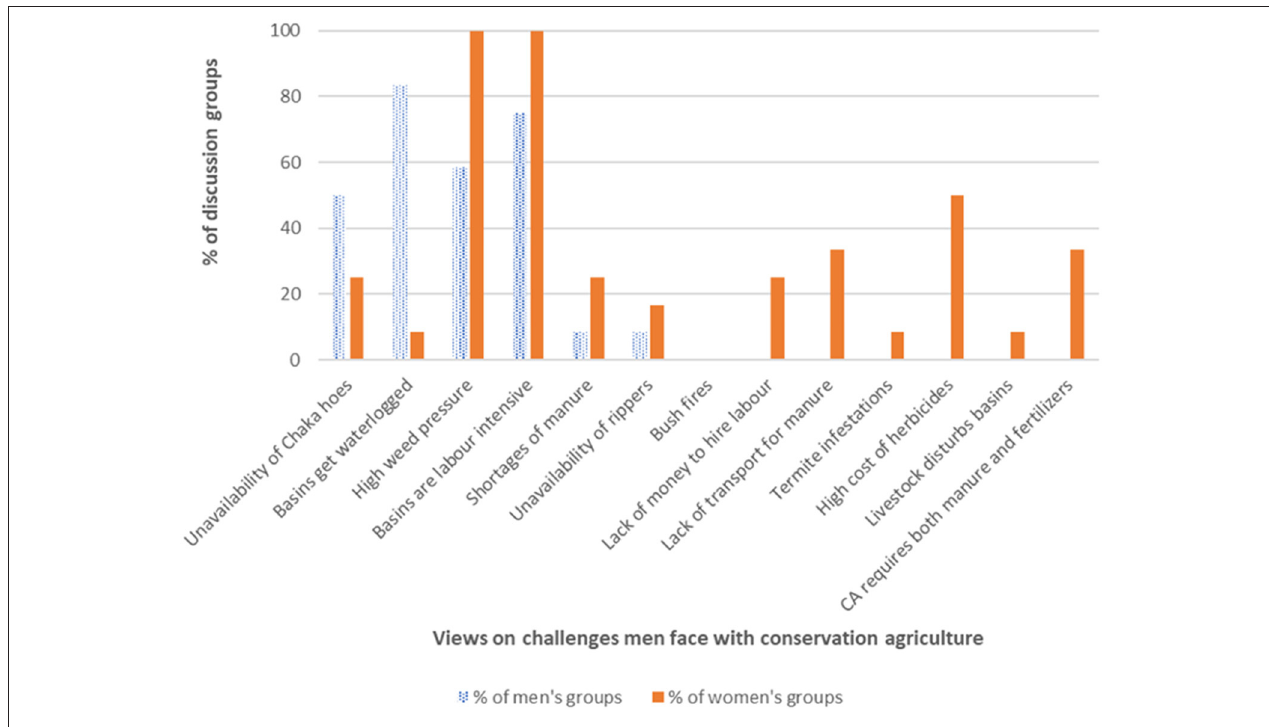
FIGURE 12 | Views on challenges of conservation agriculture for